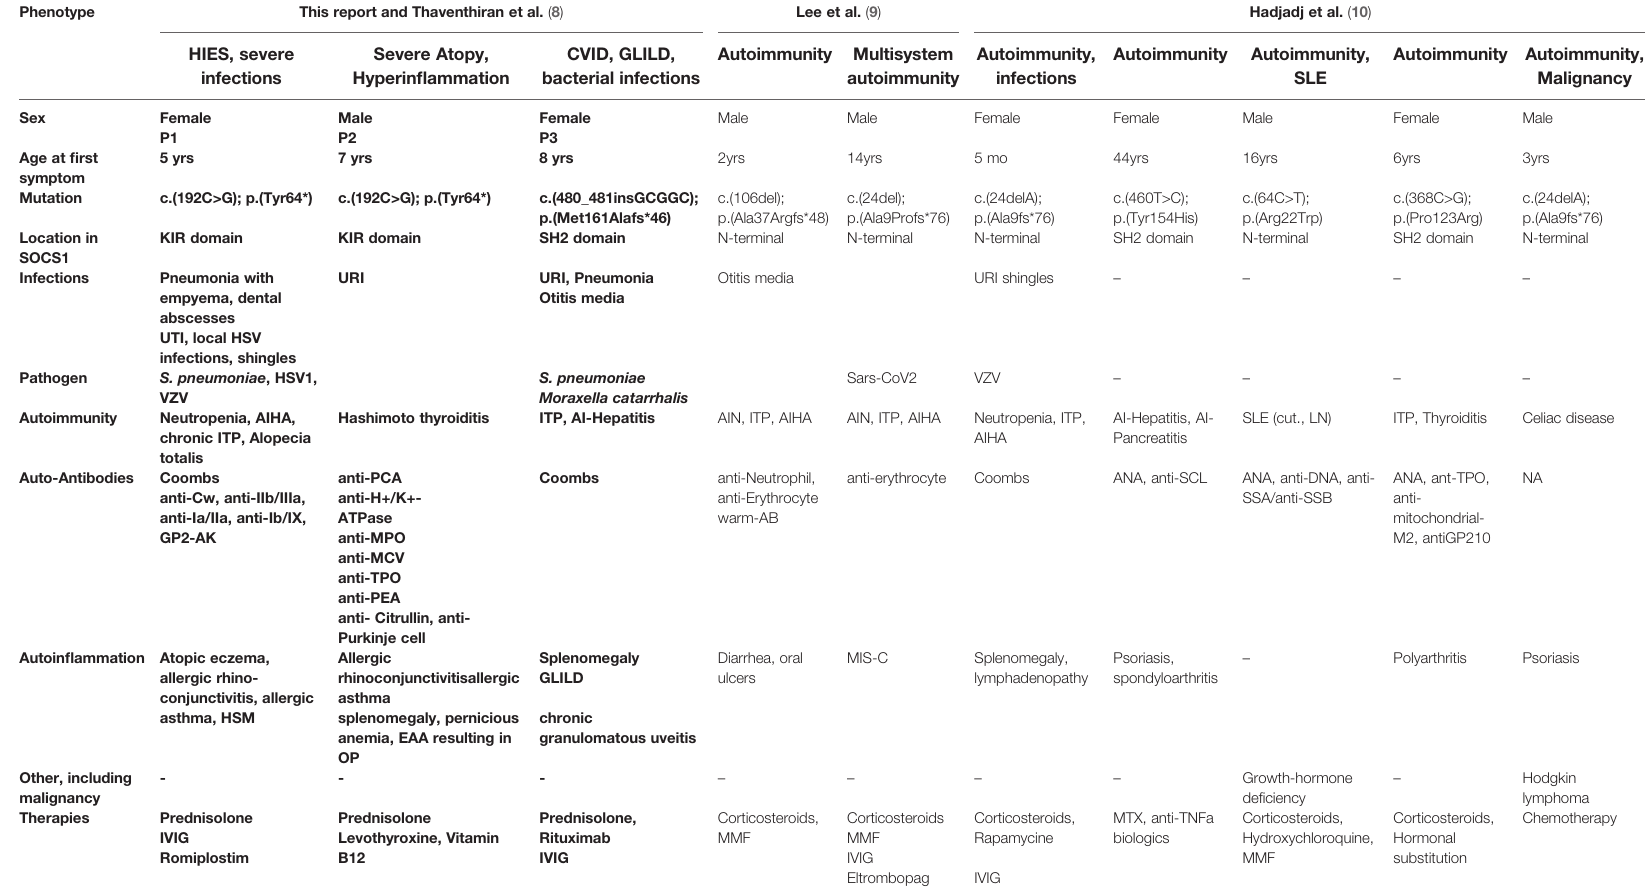
TABLE 1 | Clinical phenotypes of SOCS1 +/- patients.